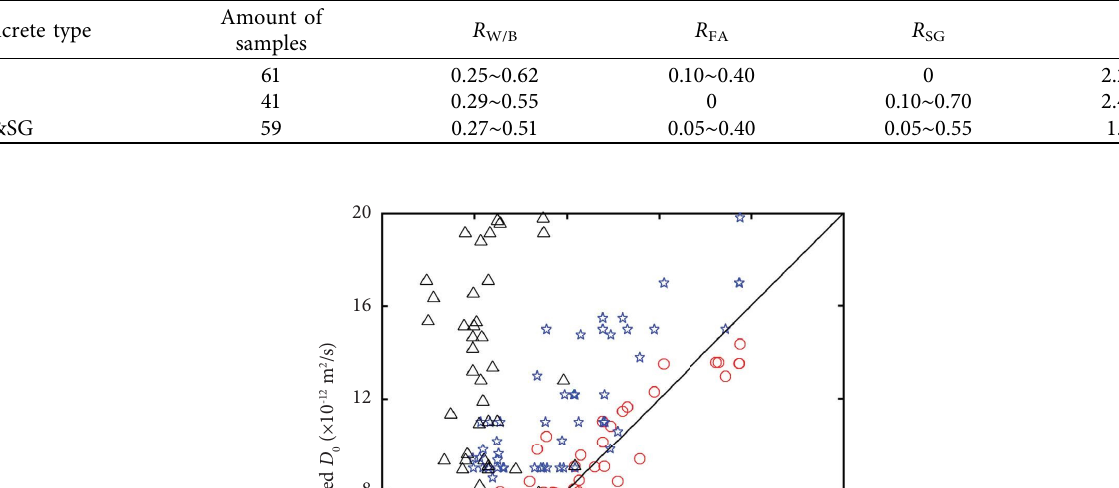
Table 2: General situation of RCM test database.